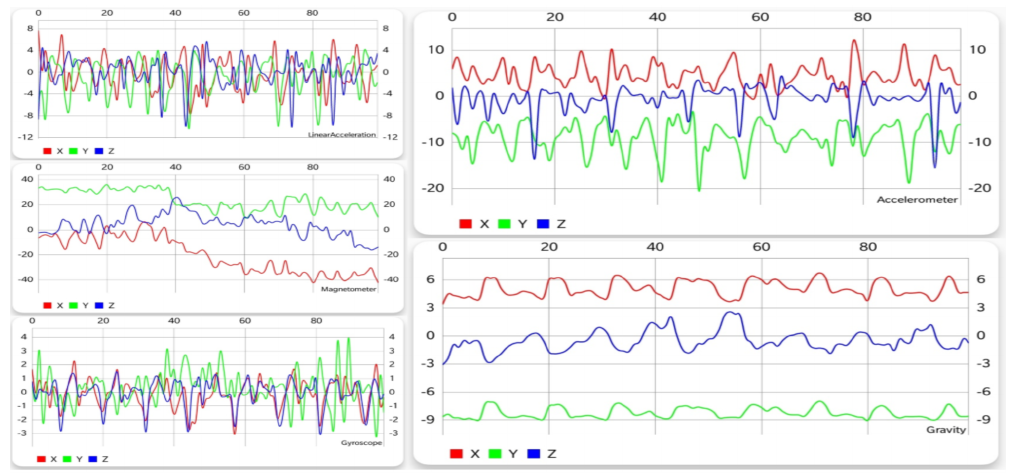
Figure 7. Graphical data gathered from each sensor while going down the stairs.